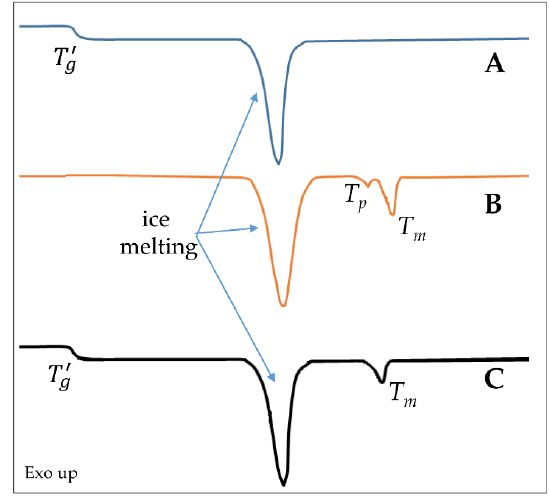
Figure 2. Schematic representation of thermal events detectable by differential scanning calorimetry (DSC) in a simplified system: ( A ) typical trace of an amorphous protectant; ( B ) typical pattern of liposomes made of a phospholipid with a T m significantly higher than melting ice temperature; ( C ) representation of an ideal thermogram registered on a liposome dispersion containing the protectant. T g ’: glass transition temperature of maximum freeze concentrate; T p : pre-transition temperature of fully hydrated phospholipids; T m : phase transition temperature of fully hydrated phospholipids.